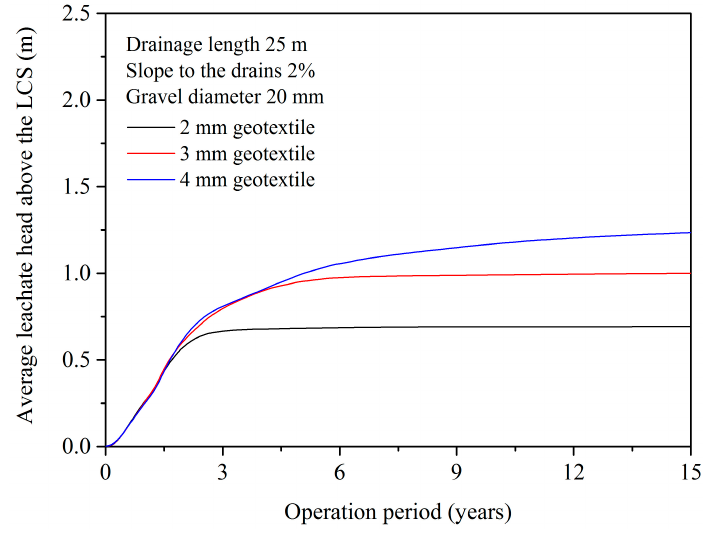
Figure 6. Average leachate head above the LCS.